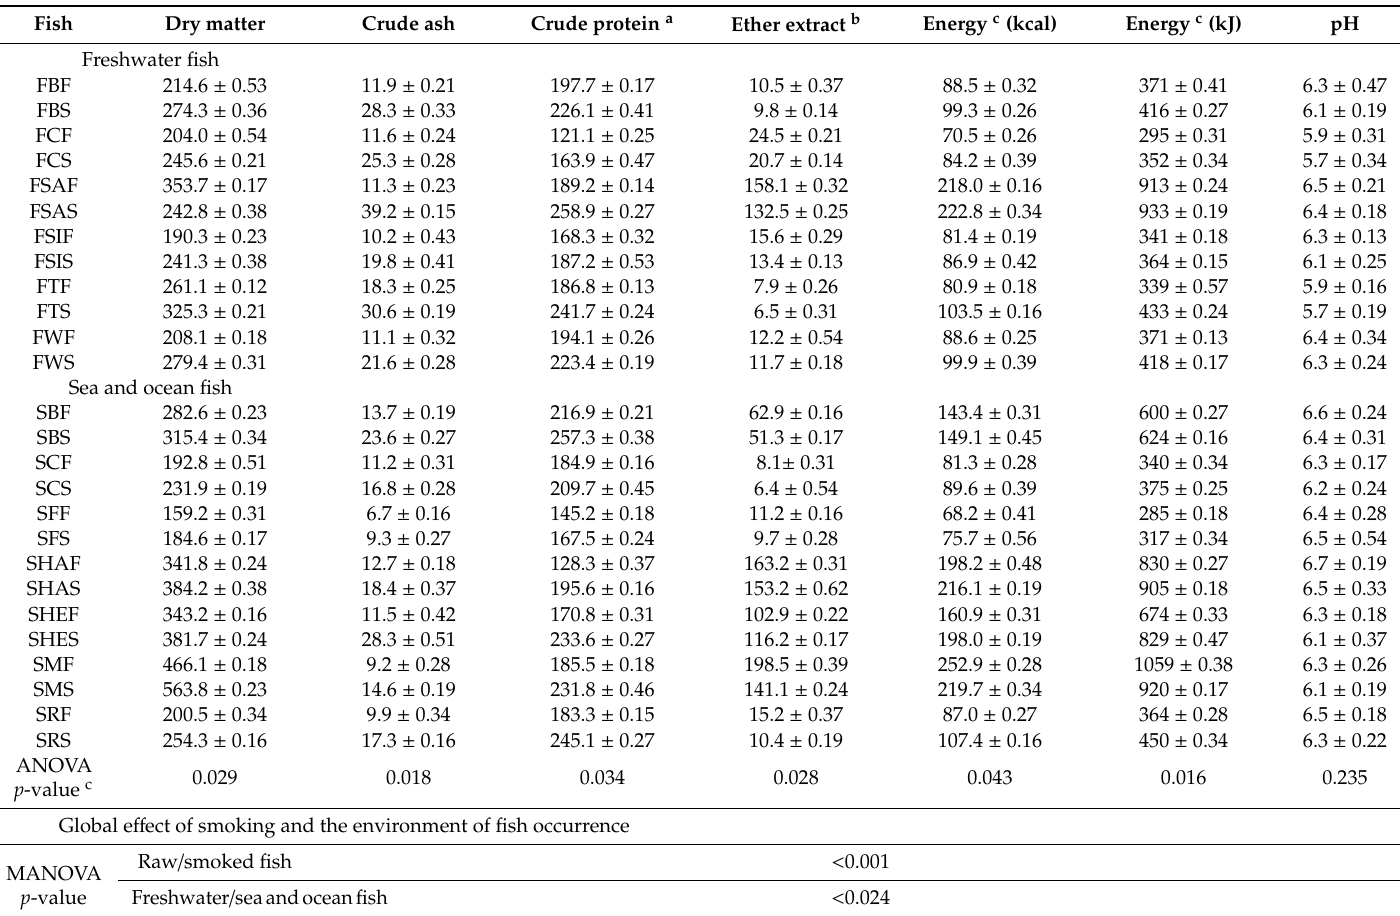
Table 2. Basic nutrients (g · kg − 1 fish) and pH of fresh and smoked